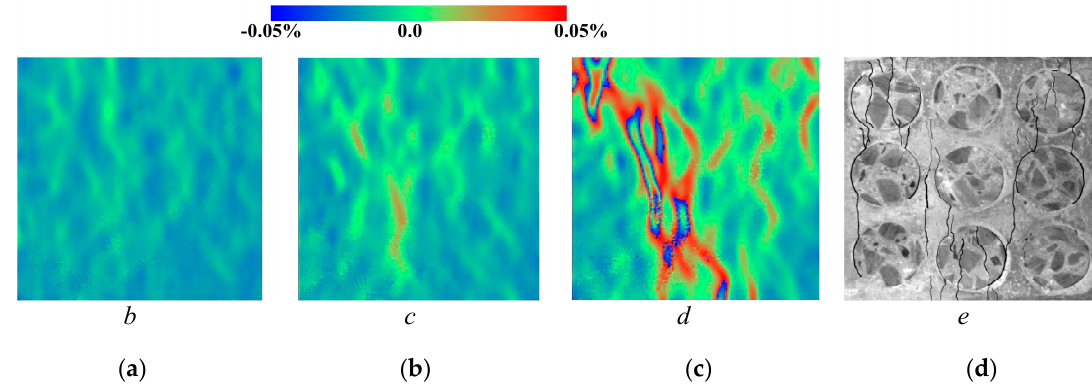
Figure 14. Lateral strain distribution contour maps from DIC measurements ( a ) loading stage b ; ( b ) loading stage c ; ( c ) loading stage d ; ( d ) loading stage e .